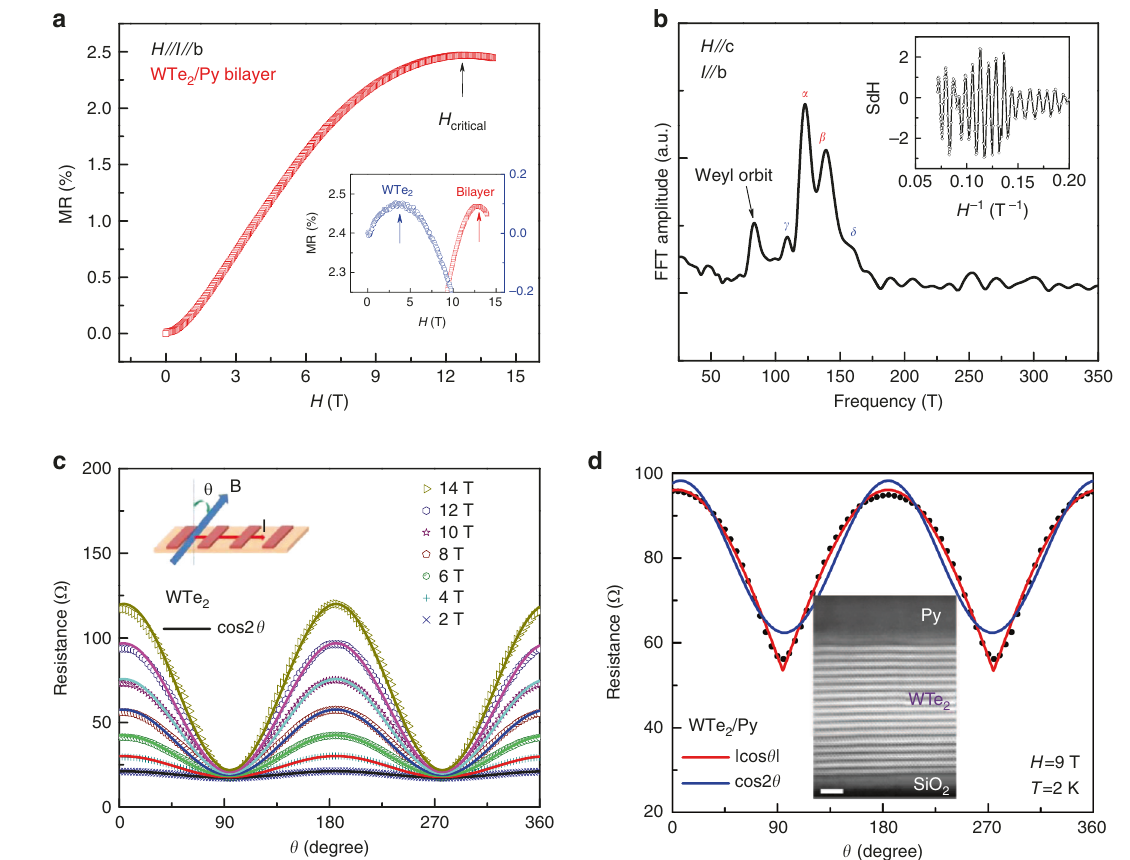
Fig. 1 Two-dimensional electronic transport and Weyl features in WTe 2 /Py bilayers. a The magnetoresistance measured on a WTe 2 /Py bilayer at 2 K with the I // H // b -axis of WTe 2 . Chiral anomaly induced negative longitudinal magnetoresistance appeared above 12 T. The blue and red symbols in the inset represent the ampli fi cation of the fi eld dependence of the longitudinal magnetoresistance of WTe 2 and WTe 2 /Py bilayers, measured at 2 K with the I // H // b -axis of WTe b -axis WTe 2 . b The FFT spectrum of the SdH oscillation of the 2 /Py bilayers. A frequency of approximately 80 T induced by Weyl orbit oscillation appeared in addition to the peak from the bulk WTe 2 . The inset shows the raw data of the SdH oscillation extracted from the longitudinal magnetoresistance data. c The angular-dependent magnetoresistance of the WTe 2 ( t = 20 nm) under different magnetic fi elds. All of the data can be well described by the cos 2 θ dependence, a feature of 3D transport. The inset schematically presents the con fi guration of the measurement. d The angular- dependent magnetoresistance of the WTe 2 /Py bilayers ( T = 2 K and H = 9 T). The data are more adequately described by a cos θ j j function than by cos 2 θ , suggesting a 2D transport mechanism in the device rather than a 3D transport mechanism. The inset contains a high-angle annular dark- fi eld cross- sectional image of WTe 2 /Py, indicating the high quality of the layers and sharp interface. The white scale bar is 2 (Supplementary Fig. 4), which may account for the quasi-2D electron transport in WTe 2 /Py and WTe 2 /Au. The observation of the 2D nature of the electron transport in both bilayers (WTe 2 /Py and WTe 2 /Au) suggests that this 2D transport may be closely associated with the topological surface state of the mechanically exfoliated (001)-oriented WTe 2 23 . Since the topological surface states are present at the top and bottom surface of the mechanically exfoliated (001)-oriented WTe 2 23 , it is therefore intriguing to investigate WTe 2 to determine whether there is a spin – momentum locking effect in its surface states and whether the effect of spin – momentum locking will enhance the spin torque in the magnetic heterostructures.